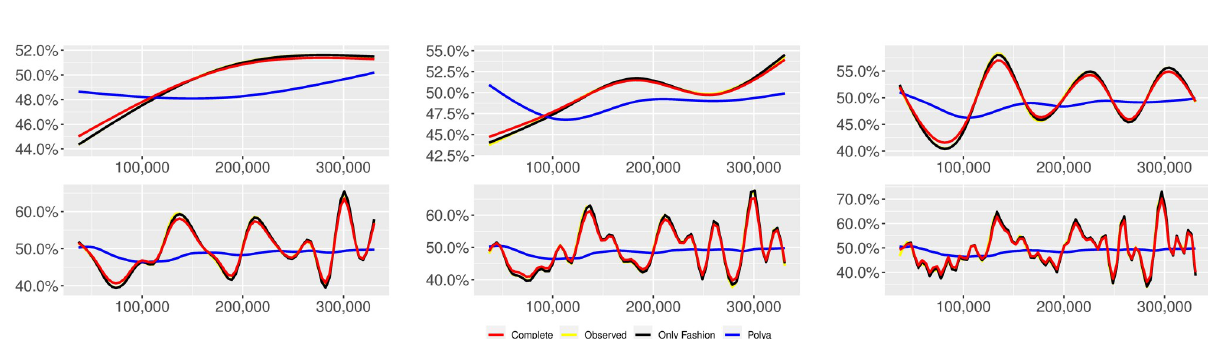
Fig 14. “Migration” ( T = 0, entire, D = 3 0 , S = 100 slots of equal size): Sentiment curves. In each panel, the yellow line is the cubic spline smoothing of the time series of the observed tweets ξ n +1 , together with the default confidence interval (gray), the red line represents the cubic spline smoothing of the time series of the estimated predictive means ^ c (defined in Subsec. 3.2), obtained with the complete RP model, the black and the blue lines provide n similar approximations obtained with the other models: black = Only fashion RP model and blue = Standard Po´lya model. In each panel, the smoothing is obtained with a given number of nodes: k = 3 (top left panel), 5 (top middle panel), 10 (top right panel), 20 (bottom left panel), 30 (bottom middle panel), 50 (bottom right panel).